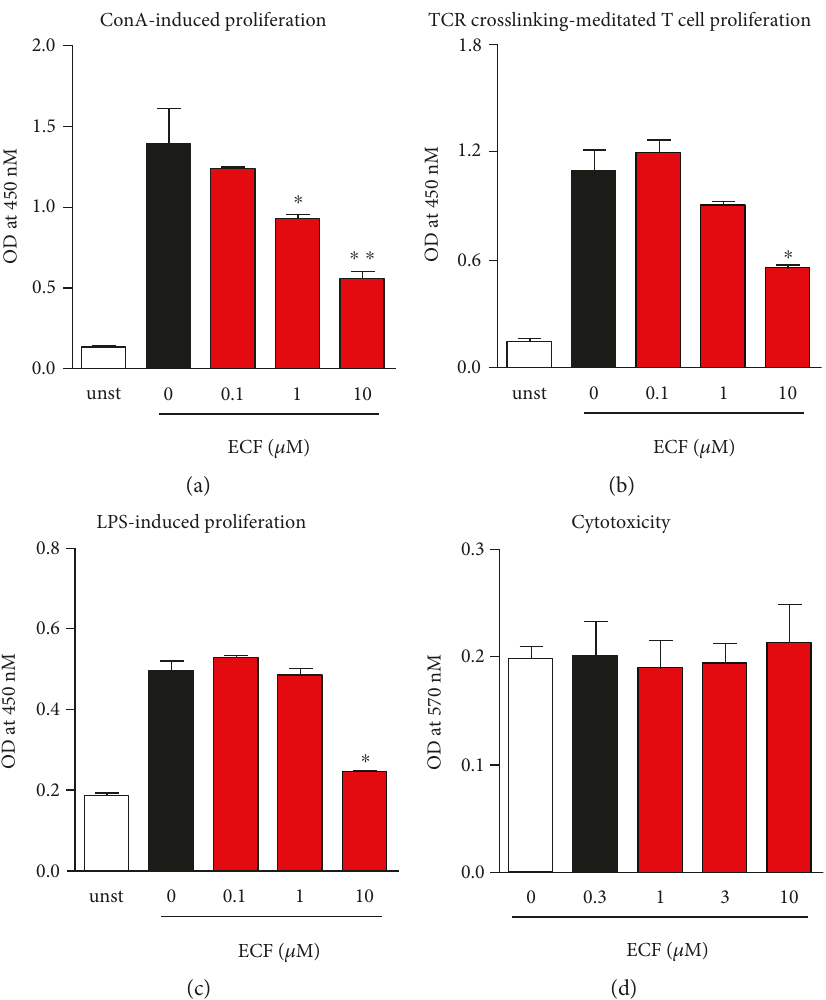
Figure 1: ECF inhibits lymphocyte proliferation in vitro. BALB/c splenocytes suspension (5 × 10 5 cells/well) or puri fi ed T cells (2 × 10 5 cells/ well) were cultured with ConA (5 μ g/ml) (a), anti-CD3/CD28 (b), or LPS (10 μ g/ml) (c) in the presence of ECF at indicated concentrations for 48h. The proliferation of lymphocytes was detected using CCK-8 Kit. The MTT method was used to measure the cytotoxicity of sample (d). Results presented are mean ± s.e.m., n = 3 . ∗ P < 0 05 , ∗∗ P < 0 01 versus control